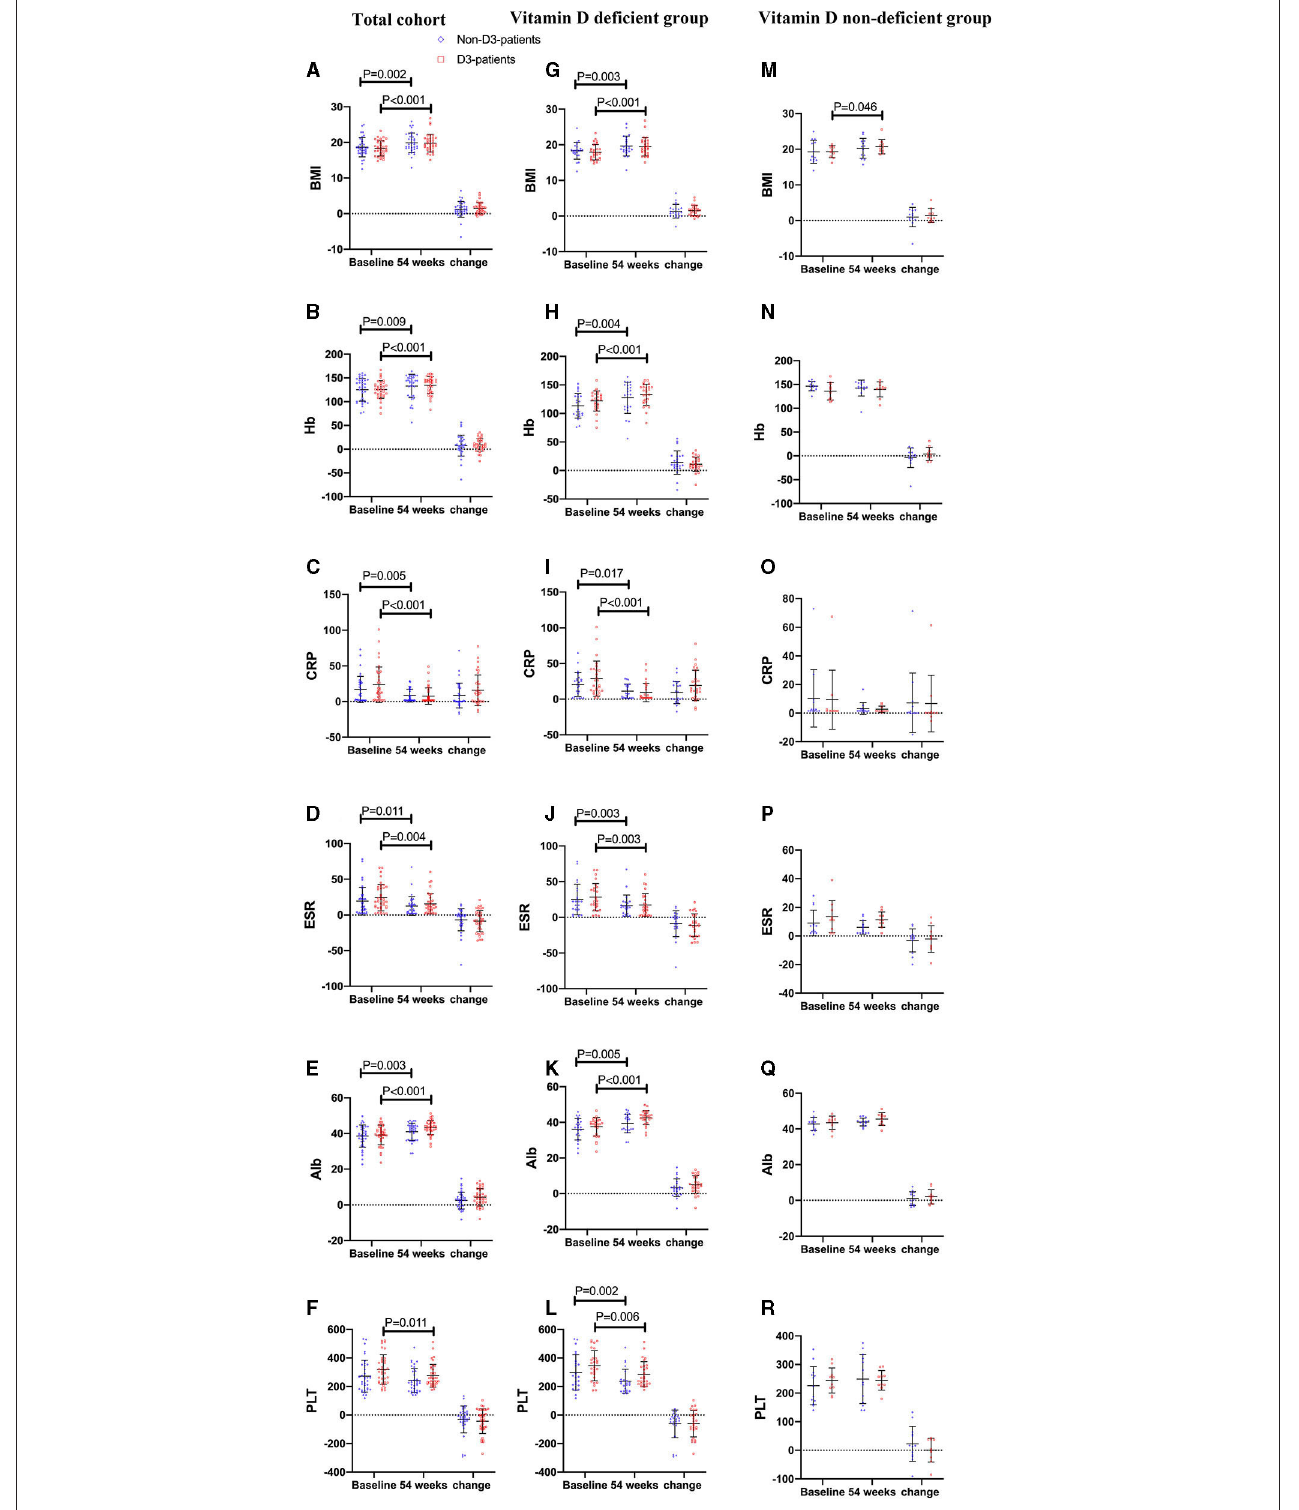
FIGURE 2 | The changes of BMI and biochemical parameters between baseline and week 54 in CD patients receiving IFX therapy. (A–F) the changes in the total cohort. (G–L) the changes in the vitD deficient group. (M–R) the changes in the vitD non-deficient group.